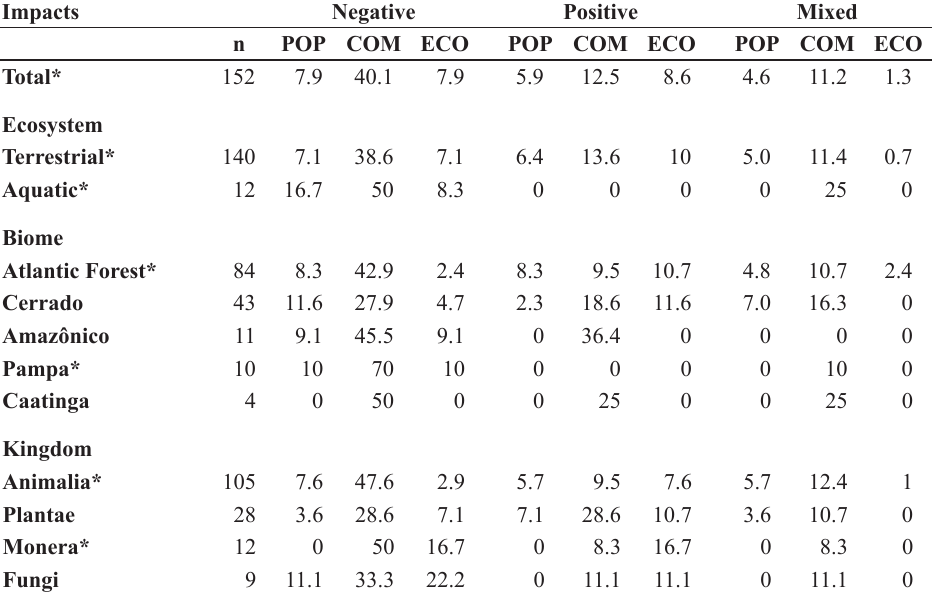
number of studies (n) and relative frequency (%) of the impacts on the population- (PoP), community- (coM), and ecosystem-levels (Eco), and the percentual contribution on ecosystems, biomes and kingdoms studied. Ecosystems highlighted with * have higher frequency of negative impacts according the chi-square